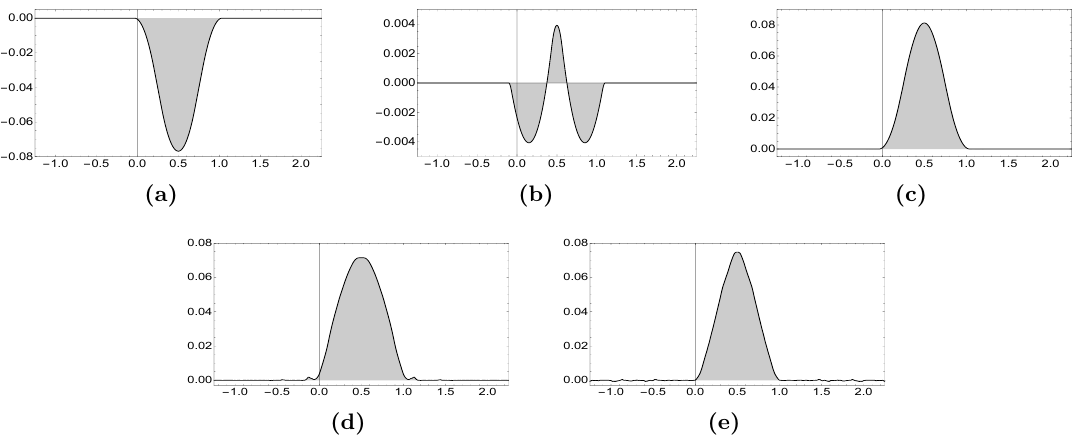
Figure 4. The signum-Gordon (cid:12)eld for (cid:15) = 1 : 2 at (a) t = 0 : 2052, (b) t = 1 : 1350, (c) t = 5 : 4025, (d) t = 5 : 6383, (e) t = 13 : 5579, (f) t = 27 :